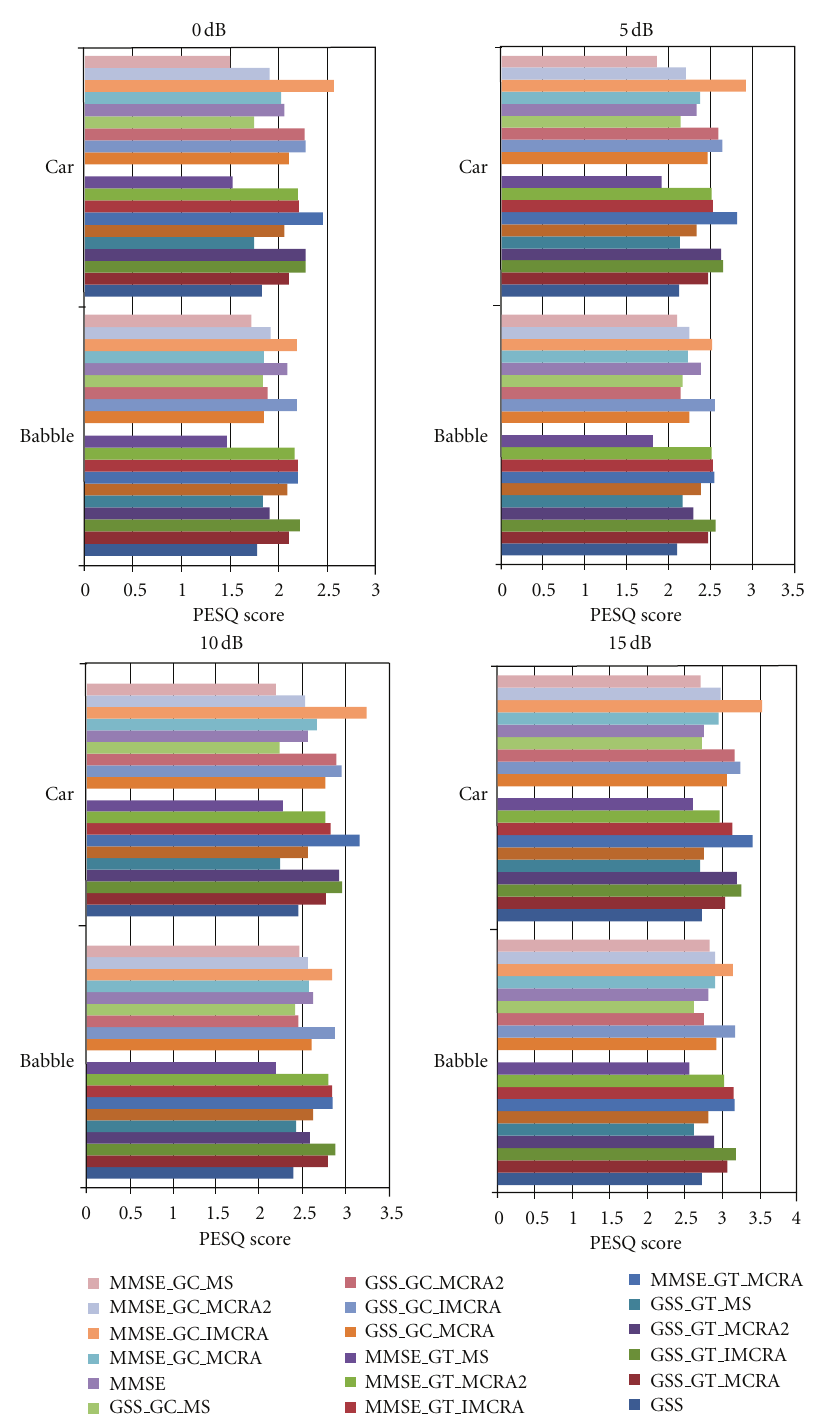
Figure 5: PESQ score for the proposed perceptual speech enhancement method based on the gammatone and the gammachirp filter banks decomposition at di ff erent signal-to-noise ratio for babble and car noise and compared to the classic